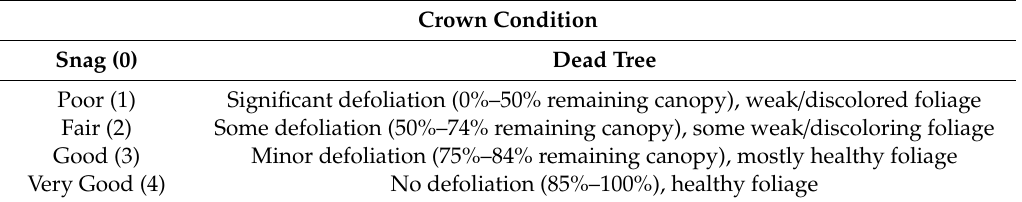
Table 1. Description of crown condition ranking system. Adapted from Neighbourwoods protocol [61].